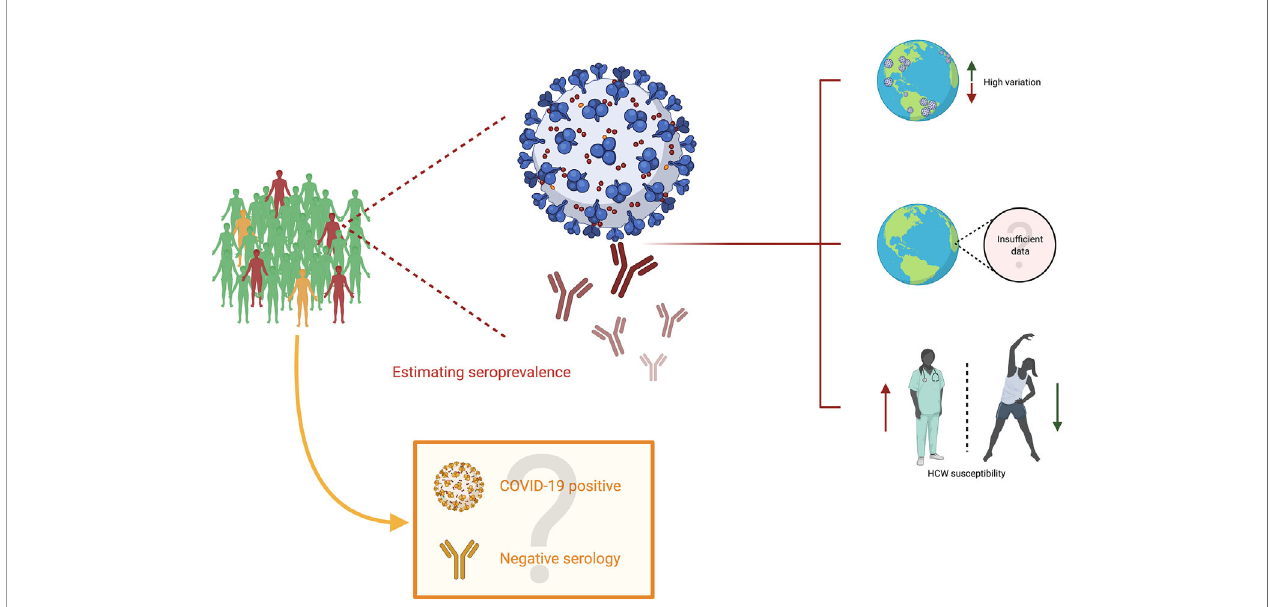
FIGURE 2 | Seroprevalence in COVID-19. Subjects in green are uninfected people (neither current nor past) with negative serology; subjects in orange are infected people (current or past) with negative serology, and subjects in red are infected people (current or past) with positive serology. Estimating seroprevalence points to three primary conclusions. First, there appears to be a high variation among different territories worldwide. Second, although efforts to characterize the impact of SARS-CoV-2 are worth highlighting, there is still insuf fi cient data to estimate the precise impact of this virus. Third, the studies on seroprevalence display the susceptibility of healthcare workers to SARS-CoV-2. However, the impact could be undermined due to individuals who become infected (COVID-19 positive) and have negative serological